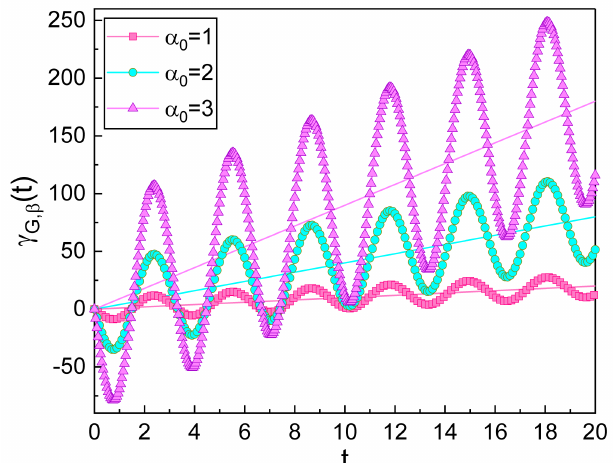
Figure 1. Temporal evolution of the geometric phase in the squeezed state for several values of α 0 . We have used ξ 0 = 1.5, λ = 0, ω = 1, ϕ = θ = 0, and γ 0 = 0. The reference lines (solid straight lines) are geometric phases drawn without quadrature squeezing for each, i.e., depicted with the choice of ξ 0 = 0. By comparing all curves, we confirm that the amplitude of the geometric-phase oscillation gradually grows according to the increase of α 0 under a quadrature